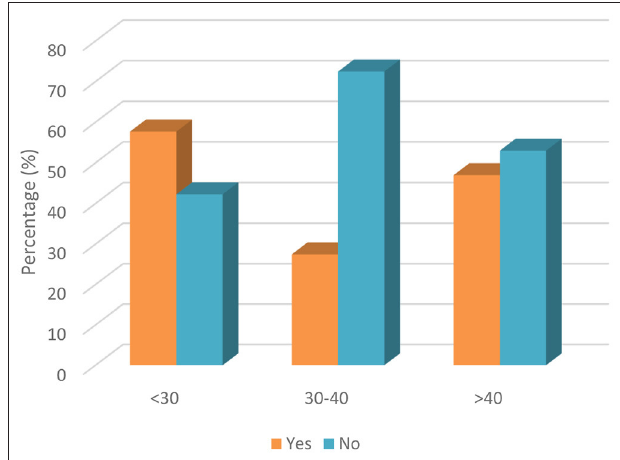
FIGURE 5 | Response of parents to whether they took any additional precautions for their children’ s oral healthcare during COVID-19 based on age